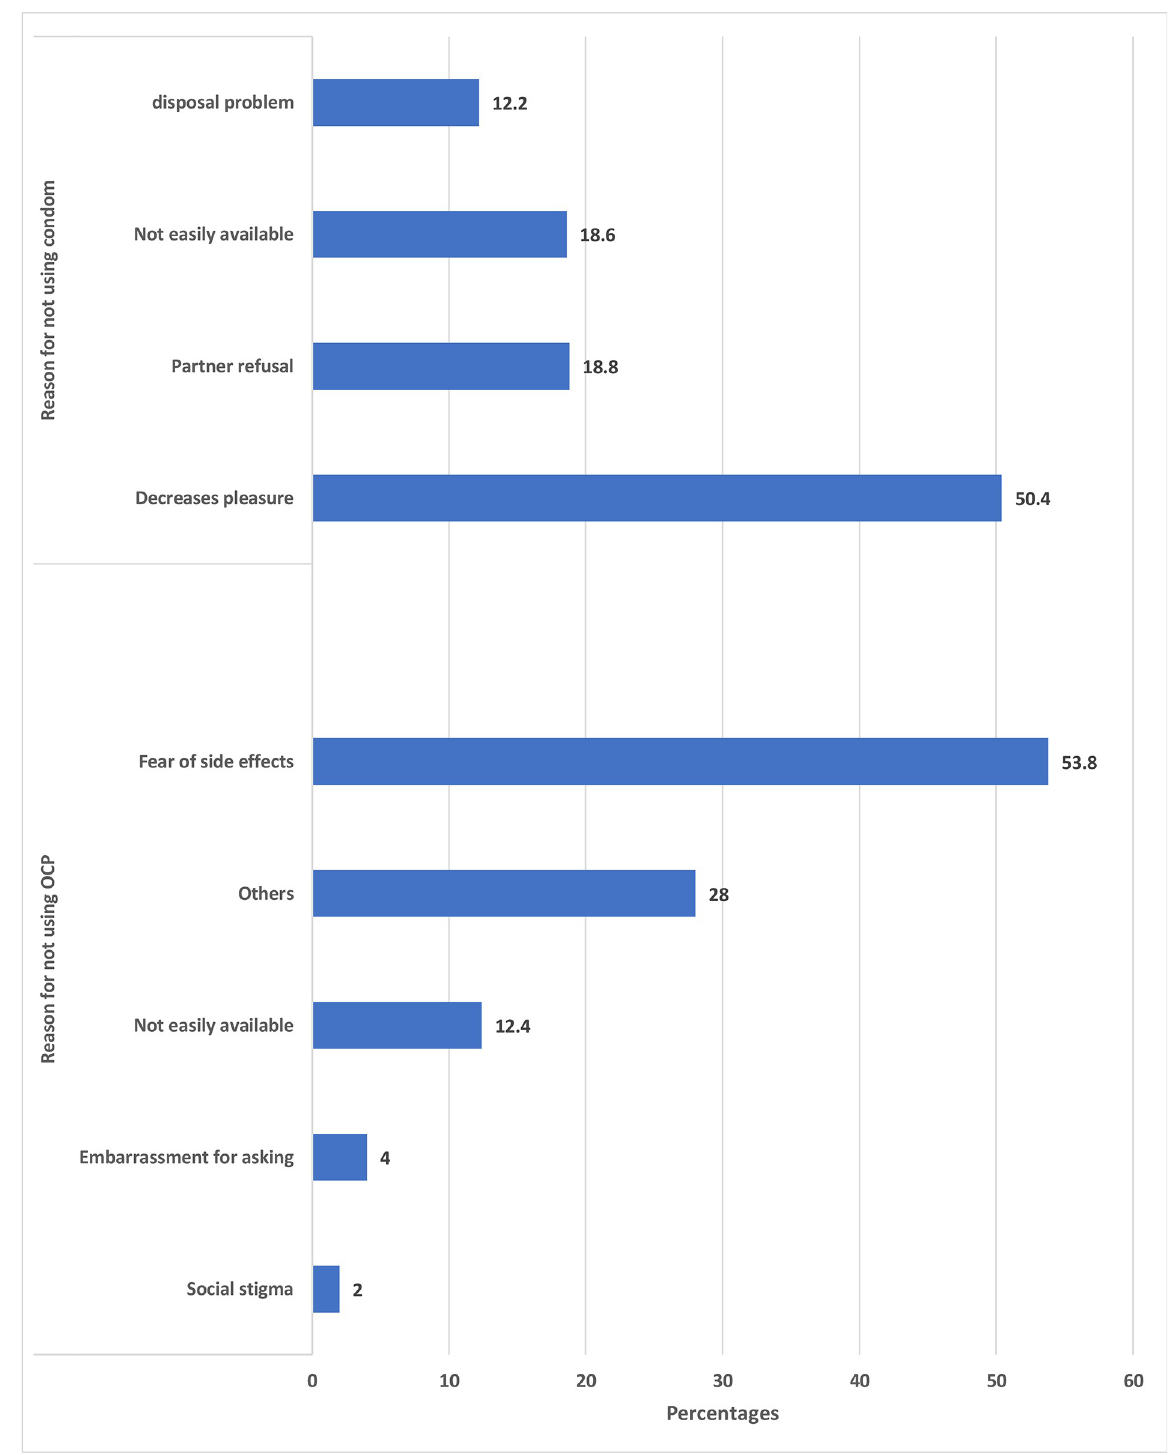
Fig 2. Reason for non-use of contraception among the university students of Bhutan.